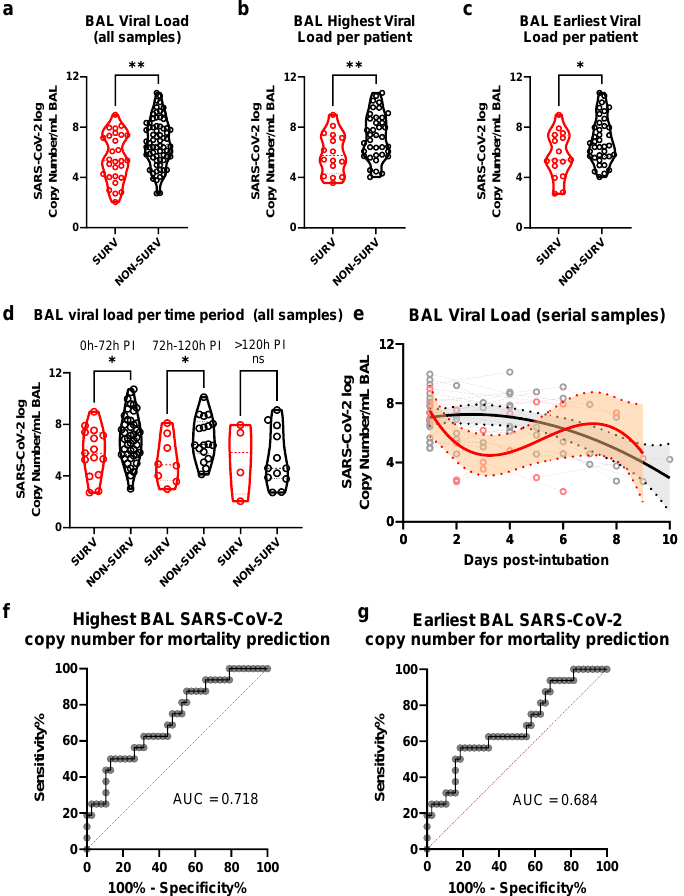
Figure 2. SARS-CoV-2 viral load in BAL samples from SARS-CoV-2 ICU patients. Bronchoalveolar lavage was performed in patients admitted to the ICU with COVID-19 associated acute respiratory failure diagnosis. In some patients, BAL sampling was performed at multiple time points. A